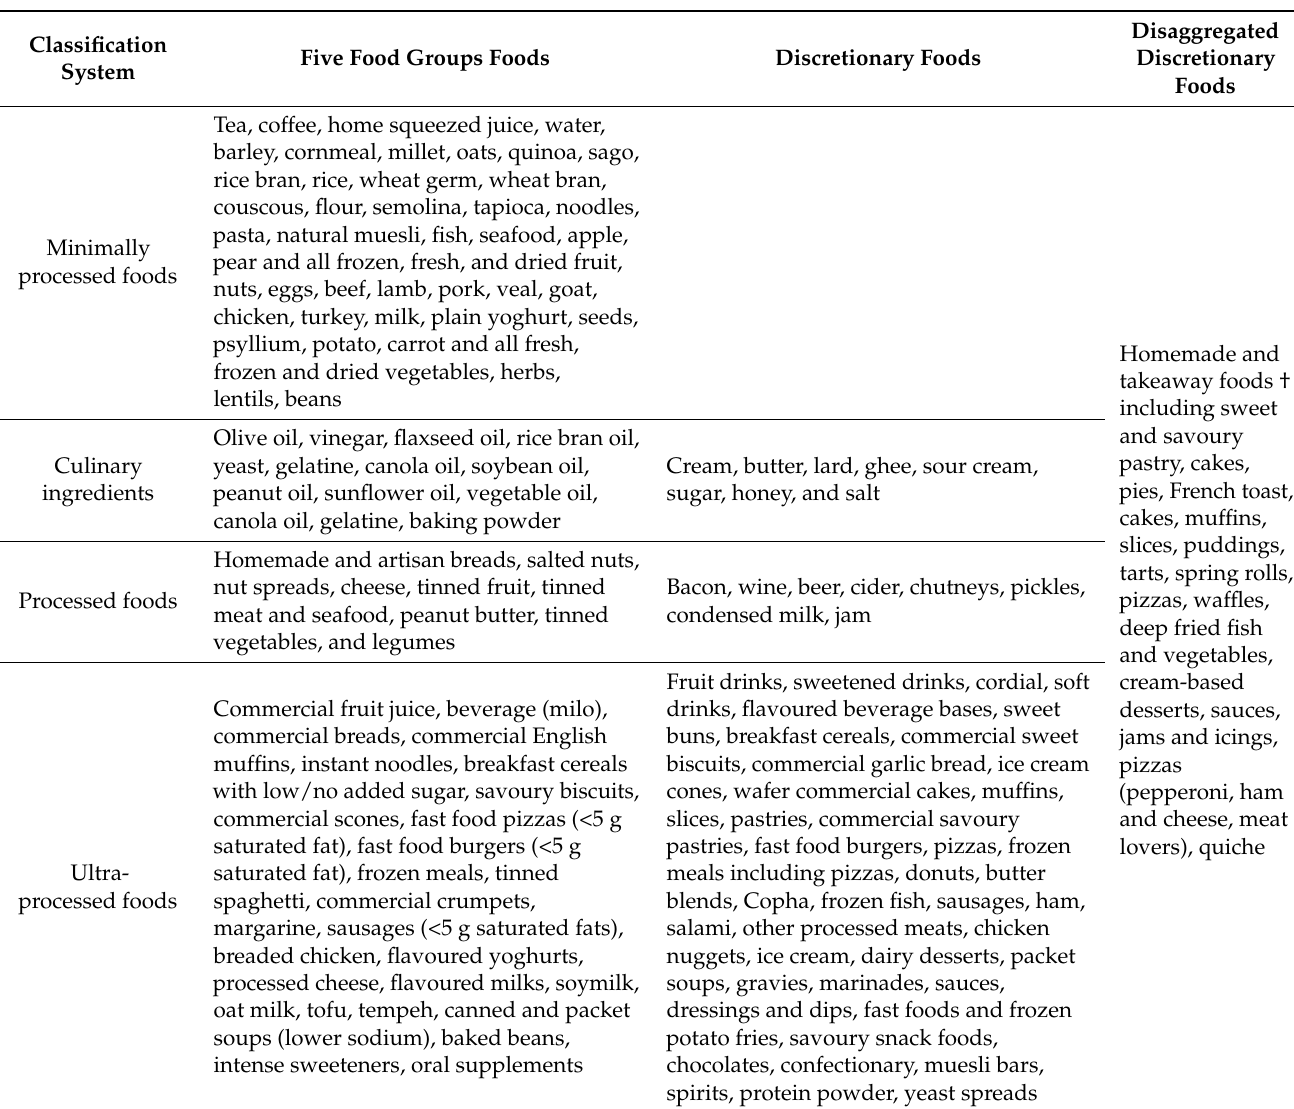
Table 1. Contribution daily energy intake (%) of selected foods by NOVA classification system and Australian Dietary